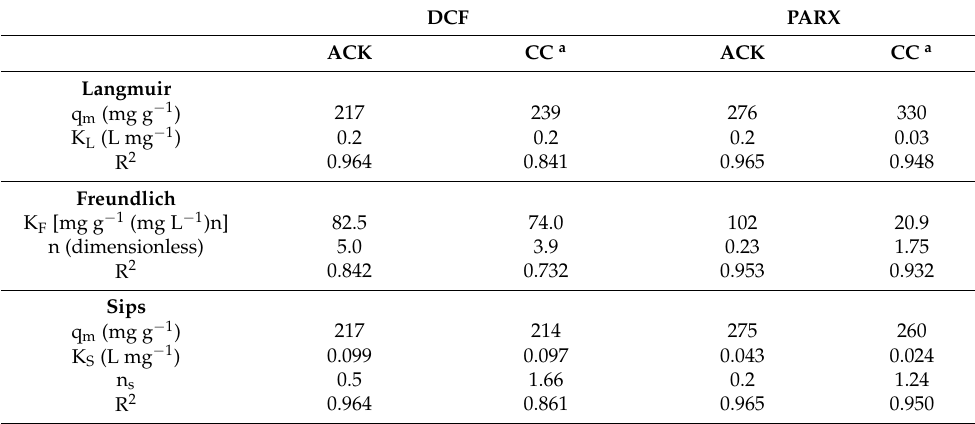
Table 7. Estimated parameters of the isotherm models adjusted to the experimental data of DCF and PARX